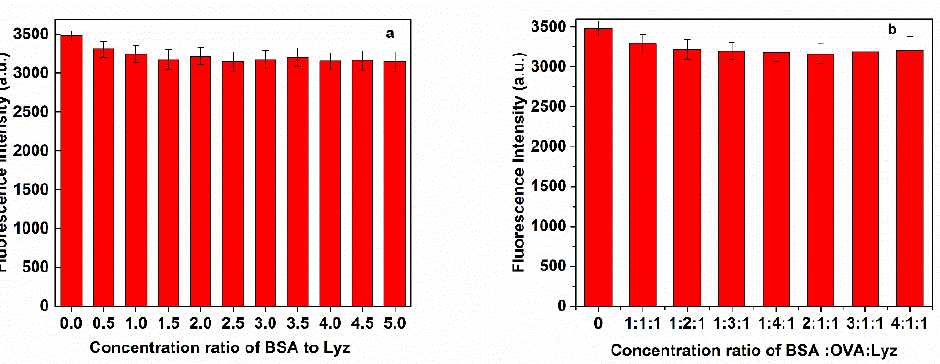
Figure 7. Competitive binding of MNP/QD@MIPs sensor with increasing concentration of ( a ) BSA and ( b ) BSA, OVA at a fixed concentration of Lyz (1.0